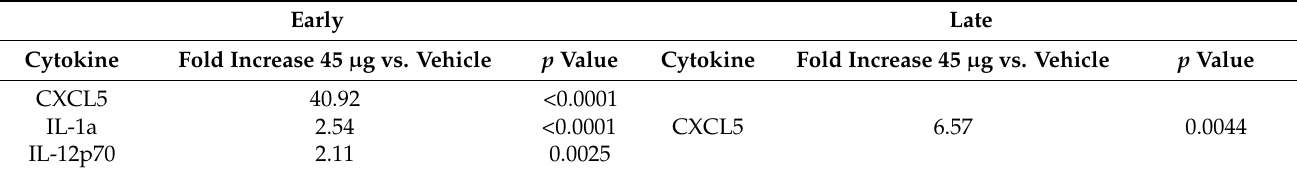
Table 2. Inflammatory markers suppressed or minimally induced by SARS-CoV-2 in mice in the vehicle group and induced in mice that received two doses of 45 µ g CoV-RBD121-NP. Early represents analysis of pooled sera from mice collected four days post-challenge; late represents analysis of serum from each mouse collected on day 10 or at virus-induced death. Statistical differences were determined by one-way ANOVA with Tukey’s post hoc test. Vehicle group, n = 7; CoV-RBD121-NP 45 µ g, n =